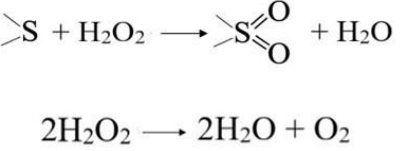
Figure 8. Processes occurring in the system sulfur-containing compound—H 2 O 2 — catalyst.